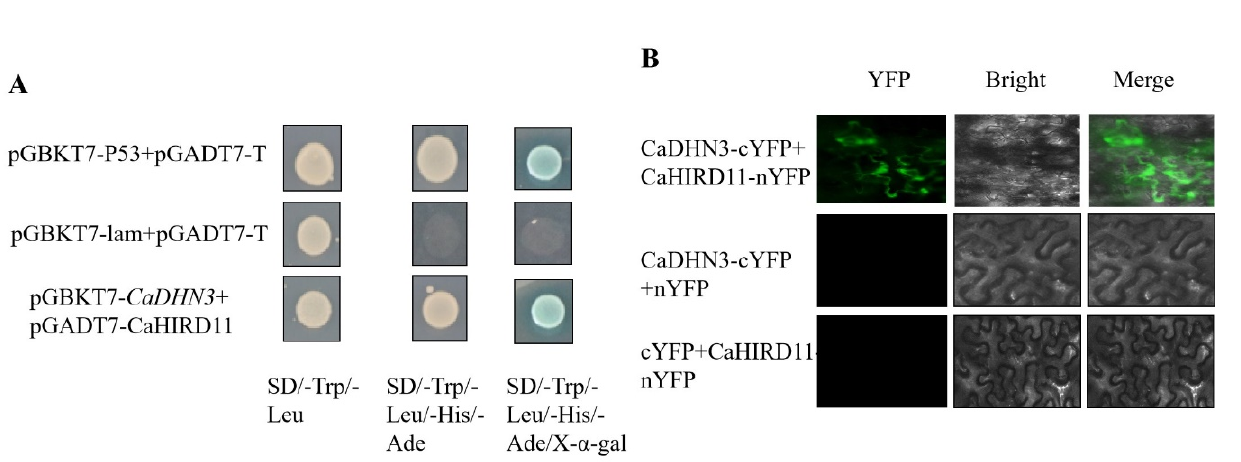
Figure 9. The interactions of CaDHN3 with CaHIRD11. ( A ) Interactions of CaDHN3 with CaHIRD11 by yeast two-hybrid assay, pGBKT7-53 + pGADT7-T as positive control, the pGBKT7-Lam + pGADT7-T as negative control. ( B ) BiFC assays were used to measure the interaction between CaDHN3 with CaHIRD11. Bars in this picture are 50 µm.